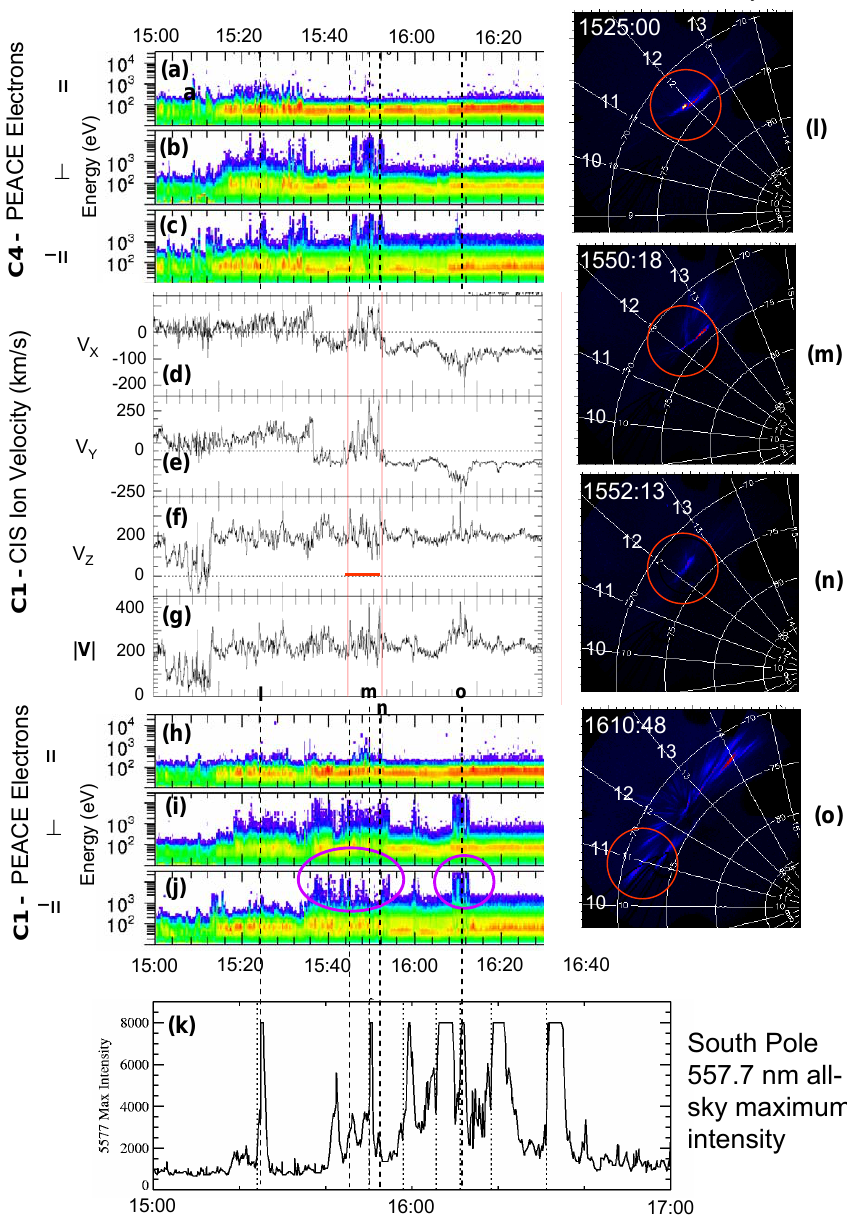
Fig. 12. Cluster 1 and 4 data compared with optics. (a–c) C4 PEACE electrons measured in directions parallel, perpendicular and anti- parallel to B . (d–g) C1 CIS proton velocity components and magnitude measured by the CODIF sensor in GSE coordinates. (h–j) C4 PEACE electrons in directions parallel, perpendicular, and anti-parallel to B . The maxima in 557.7nm emissions from South Pole (from Fig. 5) are shown for comparison. Dashed lines in panels (a–c) and (h–k) mark CIS velocity increases that have corresponding increases in the South Pole maximum intensities. Also, mono-directional electron tails appear in panels (c) and/or (j) at these times. (l–o) 557.7nm images at the four selected times noted by dashed lines. Red vertical lines in panels (d–g) designate the interval of a successful Wal´en test (Fig.